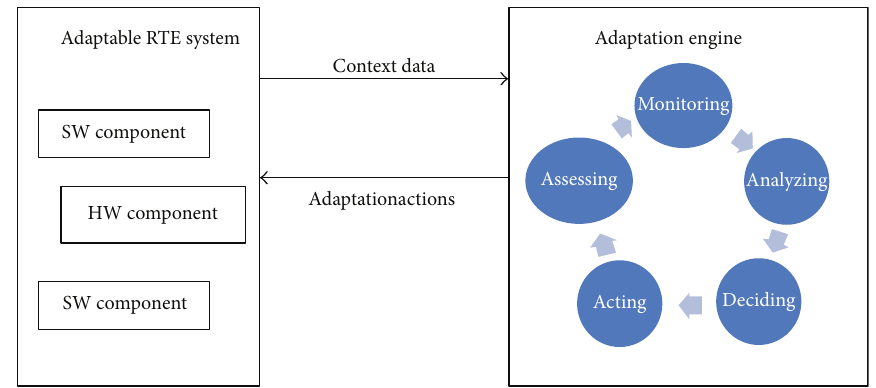
Figure 1: External adaptation approach: adaptable system + adaptation